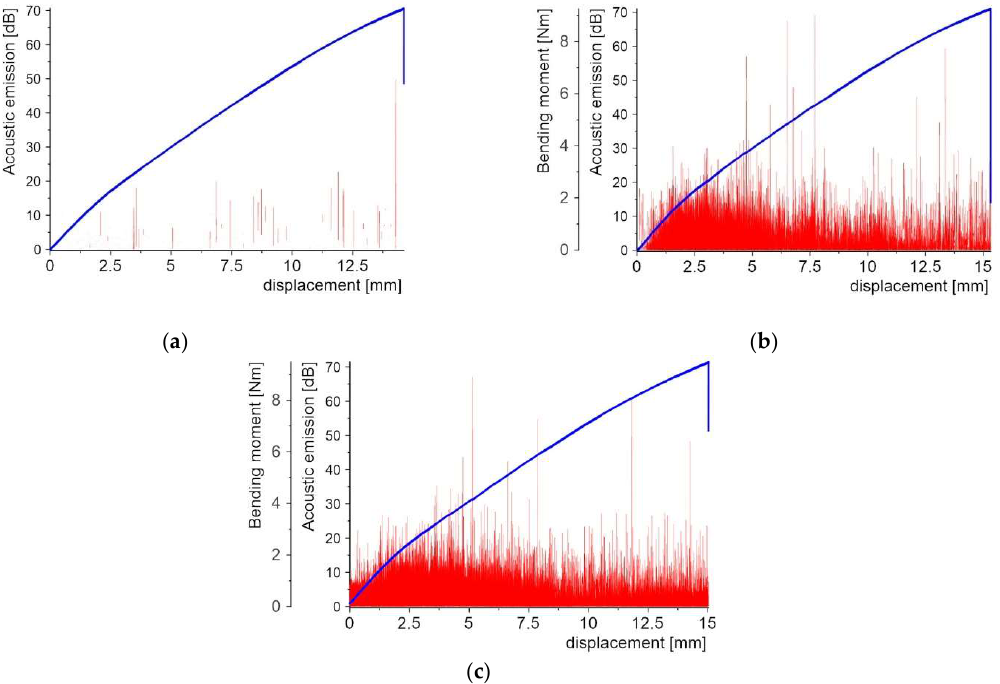
Figure 11. dB, mainly before the specimen final failure, are noticeable. The bending moment-dis- Figure 11. Bending moment and AE vs. displacement diagrams for specimens with aluminum placement diagrams are continuously increased, almost linearly, without any visible drop before powder PL: ( a ) sample 4_1; ( b ) sample 4_2; and ( c ) sample 4_3. the maximum failure load. The absence of brittle fracture indicates that plastic deformation is oc-